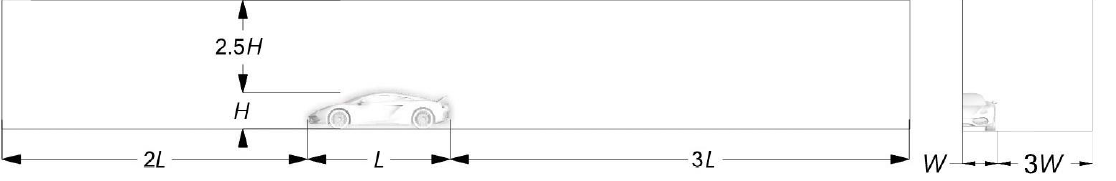
Figure 20. Size of the computational domain with length L = 4.6 m height H = 1.1 m and width W = 1.1 m. Meshes were generated in Fluent Meshing 2022R1. A relatively uniform surface mesh was generated on the car body (Figure 21). Mesh refinement in the region of high velocity and pressure gradients was provided by box-shaped bodies of influence (BOIs) around the car body and in the undercarriage area. A poly-hexcore algorithm was chosen for the volume mesh.